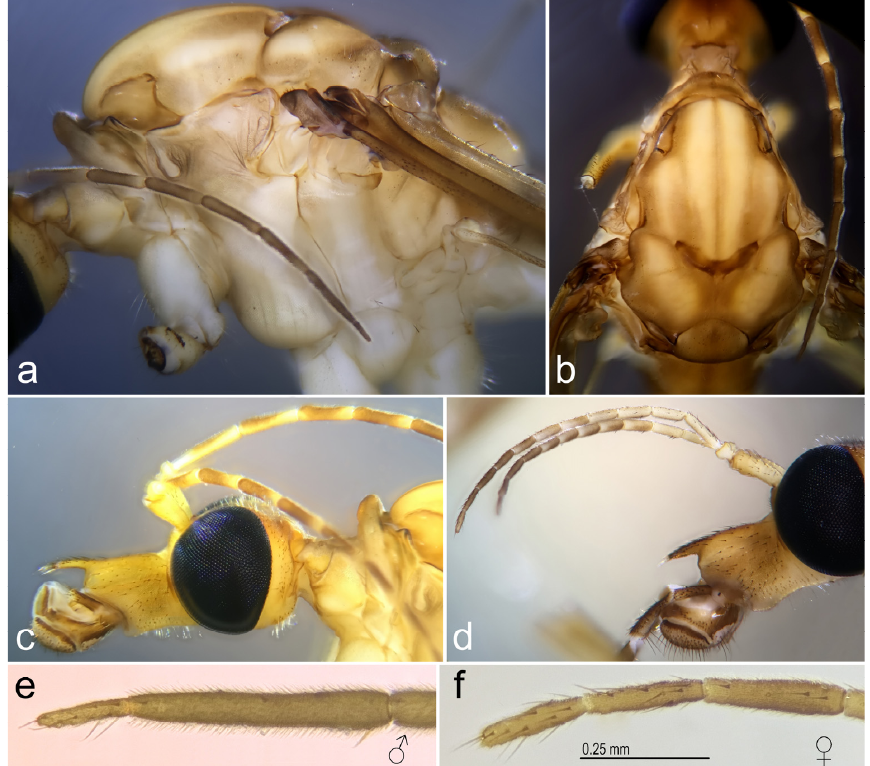
Figure 7. Zelandotipula gelhausi sp. nov . , holotype male; ( a ) Thorax and antenna, lateral view; ( b ) idem , dorsal view; ( c ) Head and antennae, lateral view; ( d ) idem paratype female, lateral view; ( e ) Terminal flagellomeres of holotype male; ( f ) idem of paratype female.